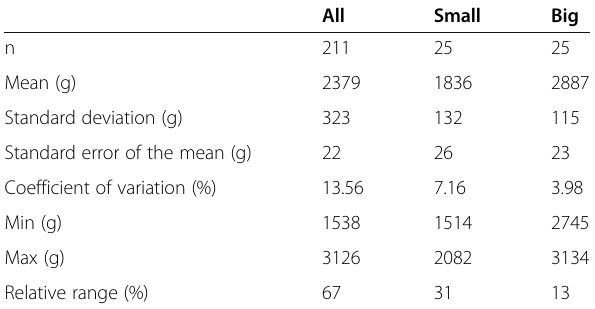
Table 1 Descriptive statistics of body weight after 37 days of rearing. The incongruence between the min-max values for “ All ” birds (1538 – 3126 g) versus the Min value for Small birds (1514 g) and Max value for Big birds (3134 g) is explained by a time- difference of up to 6 h in between weighing #1 of all birds leading to the sorting of the 25 heaviest and 25 lightest birds and weighing #2 of the subset of 50 birds immediately before